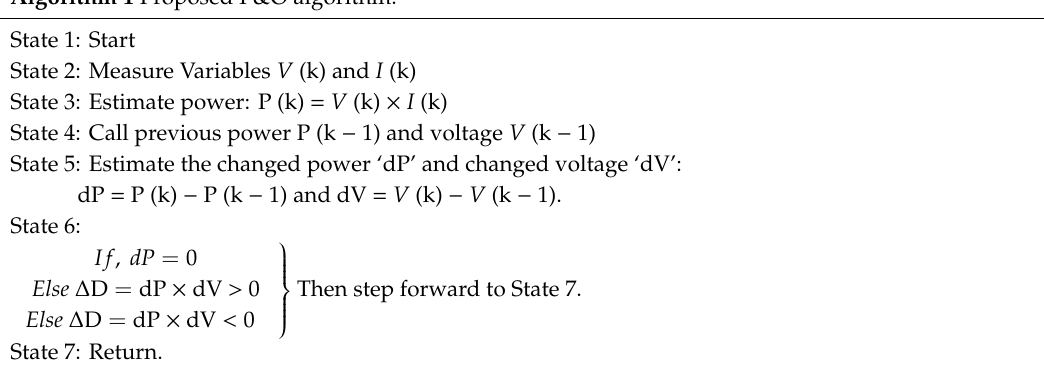
Algorithm 1 Proposed P&O algorithm: